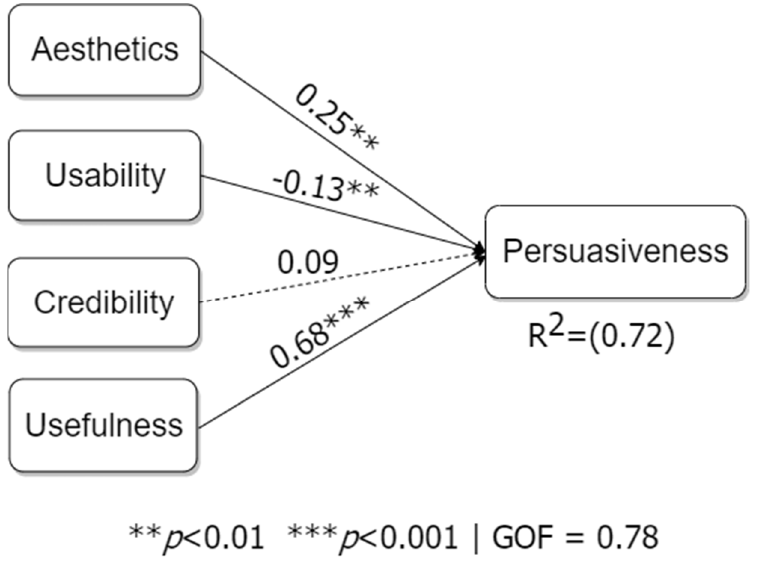
Figure 3. Model of the relationship between perceived UX design attributes and users’ receptiveness to persuasive features of a fitness app.